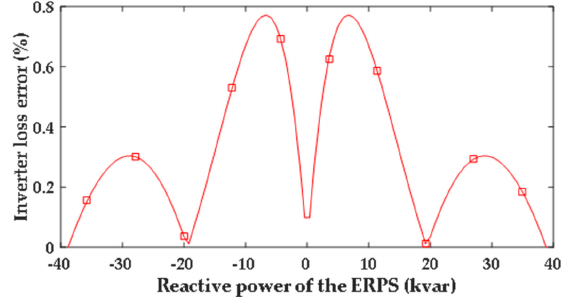
Figure 5. Error in the inverter power loss model.